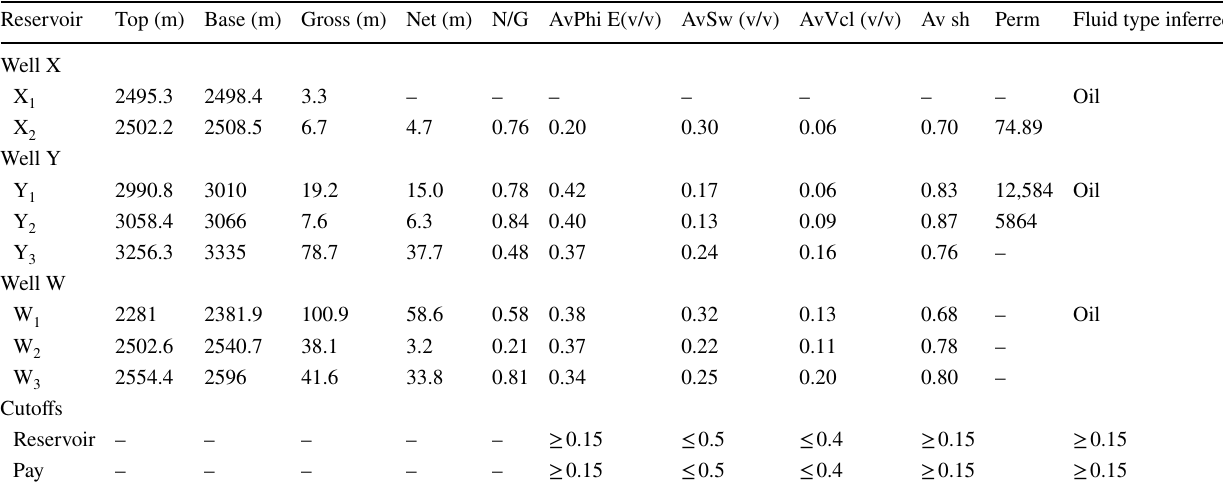
Table 1 Average petrophysical parameters for reservoirs in wells W, X, Y and Z